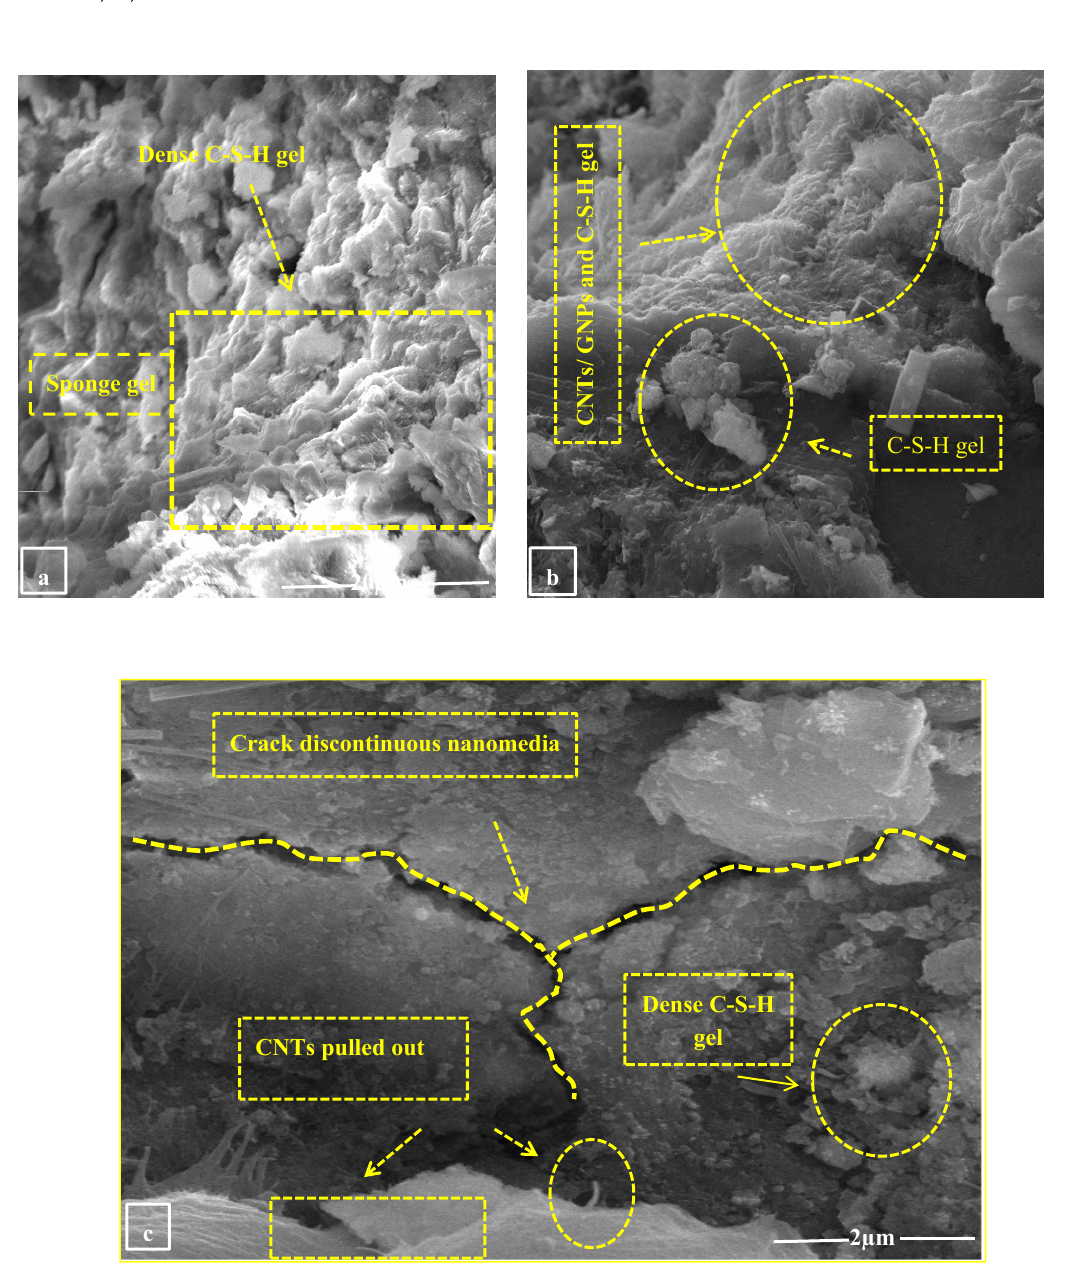
Figure 20. ( a and b ) Dense sponge C-S-H gel, ( c ) crack discontinuity by nanomedia. Figure 20. ( a ) and ( b ) Dense sponge C-S-H gel, ( c ) crack discontinuity by